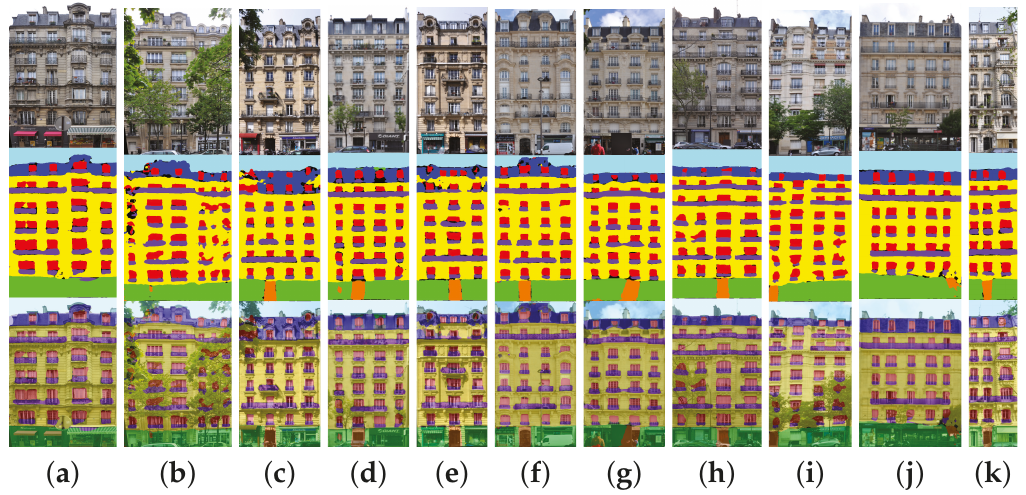
Figure 8. Results over the ENPC dataset. ( a – k ) Example of ENPC images, segmented by the neural model presented in Section 4.1.2. The three different rows correspond to the same description as in Figure 5.